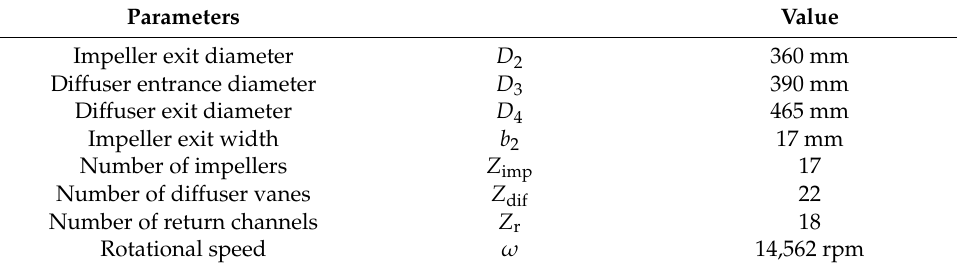
Table 1. Primary geometric parameters of the centrifugal compressor